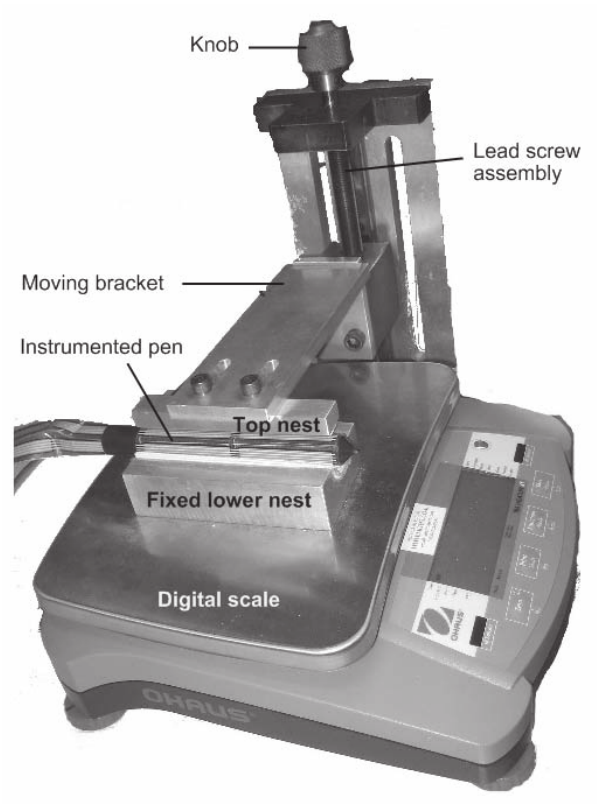
Figure 2. The calibration setup. Each sensor in the force sensor array was calibrated using this setup through loading and unloading of the sensors.